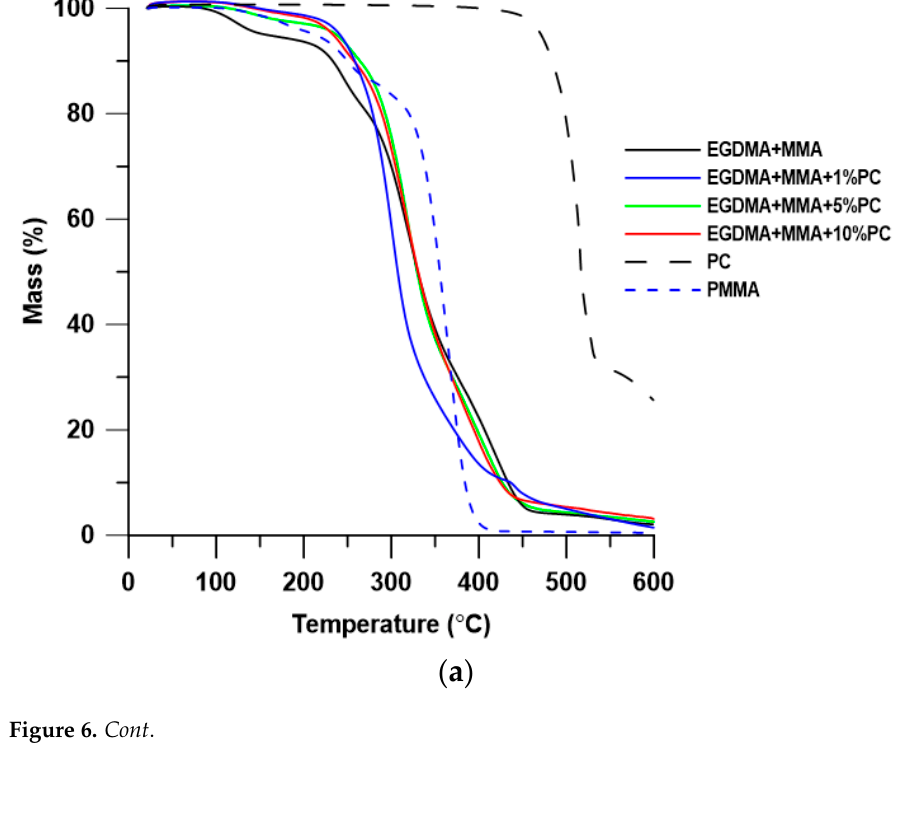
Figure 5. TG ( a ) and DTG ( b ) curves of BPA.GDA + MMA based blends.